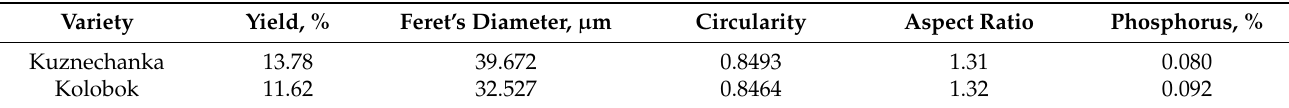
Table 1. Average yield, morphological data, and phosphorus content for potato varieties studied. Variety Yield, % Feret’s Diameter, µ m Circularity Aspect Ratio Phosphorus, % Kuznechanka 13.78